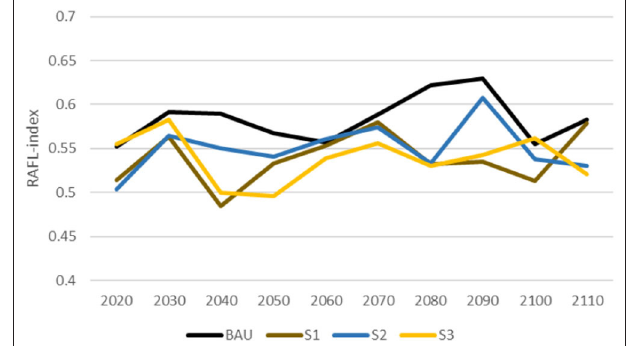
FIGURE 6 | Ten-year average RAFL-index over the planning horizon for the four